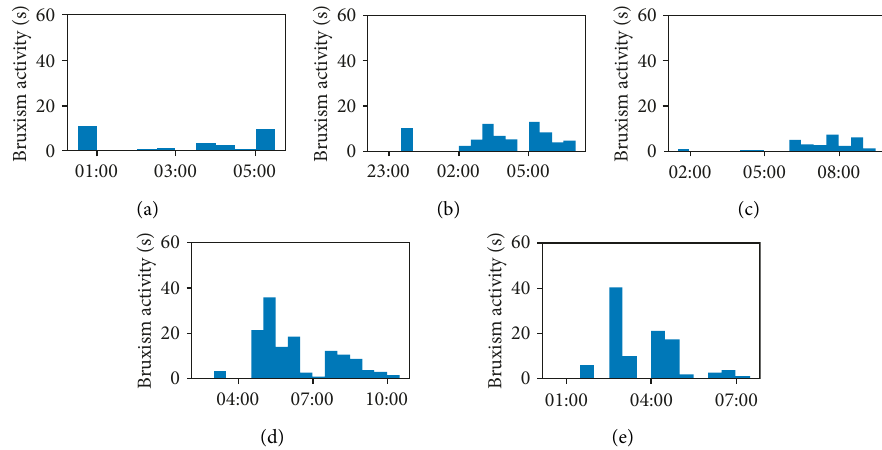
Figure 7: (a–e) Establishment of the bruxism severity during 5 nights of recording with the biofeedback